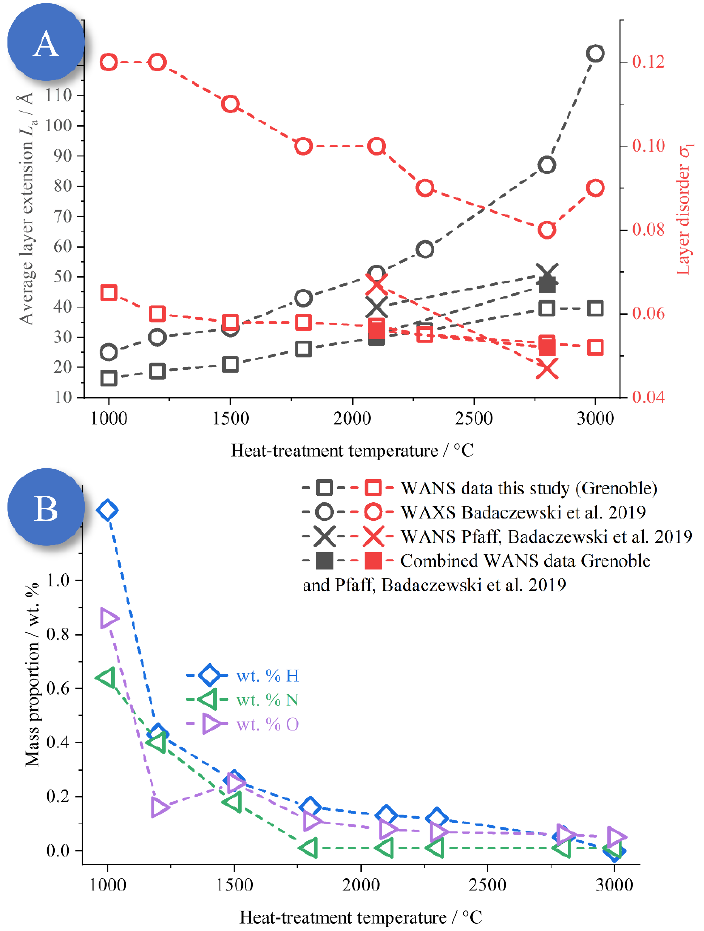
Figure 12. ( A ) : Comparison of the layer extension ( L a ) and disorder ( σ 1 ) with elemental analysis ( B ) for phenol-formaldehyde resin (PF-R) as precursor. Foreign atoms such as oxygen and nitrogen hinder the formation and lateral growth of graphenes (in the form of carbonyl groups, -OH groups, etc.). Therefore, a decreasing concentration of elements leads to bigger and more highly ordered graphene layers. The values of L c and σ 3 are not shown here, because the trends were quite similar to ( L a ) and disorder ( σ 1 ). The corresponding figures for MP and LSPP can be found in the SI file (Figures S12 and S13). The data used can be found in the works of Badaczewski et al. (2019) [37] and Pfaff et al. (2019) [43].